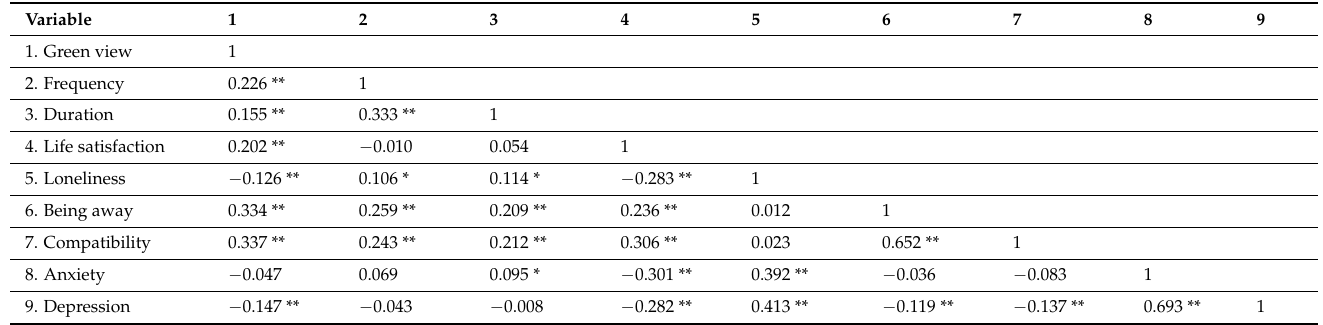
Table 3. Spearman’s correlation analysis for the measured